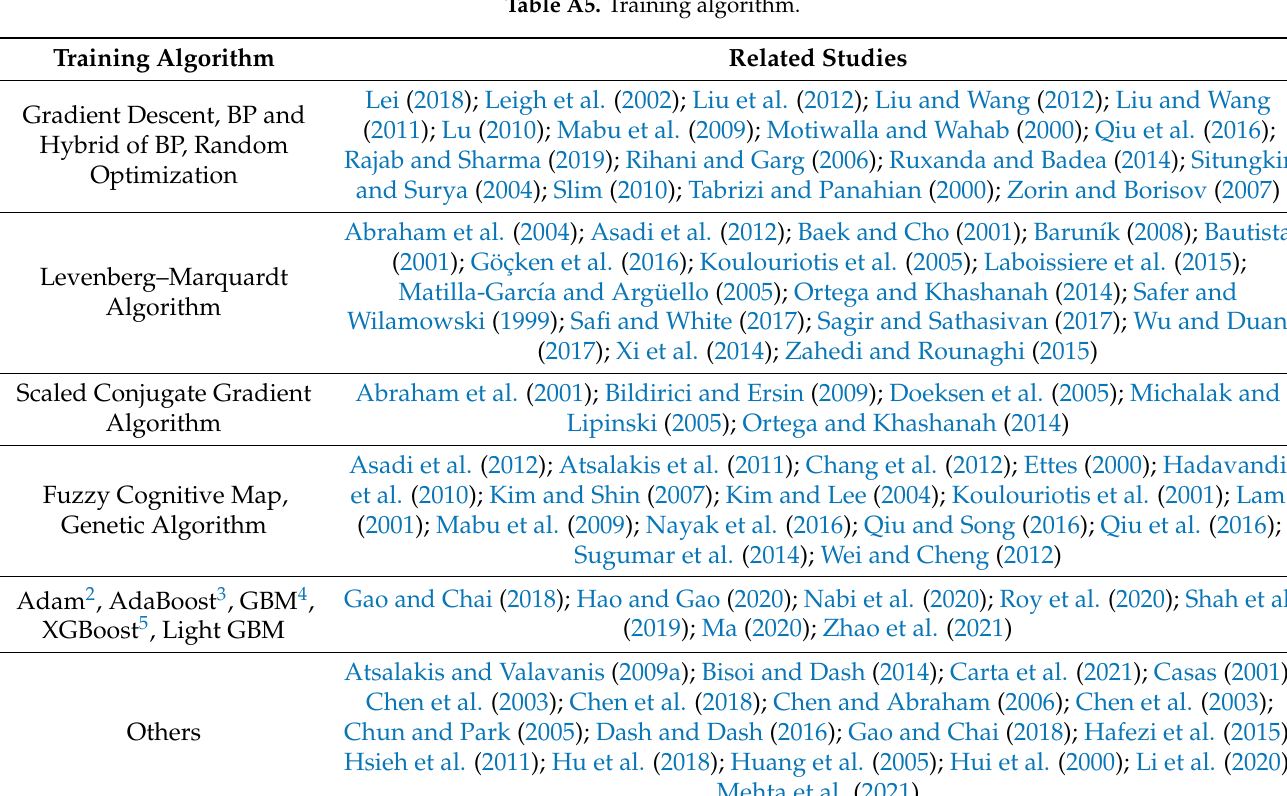
Table A5. Training